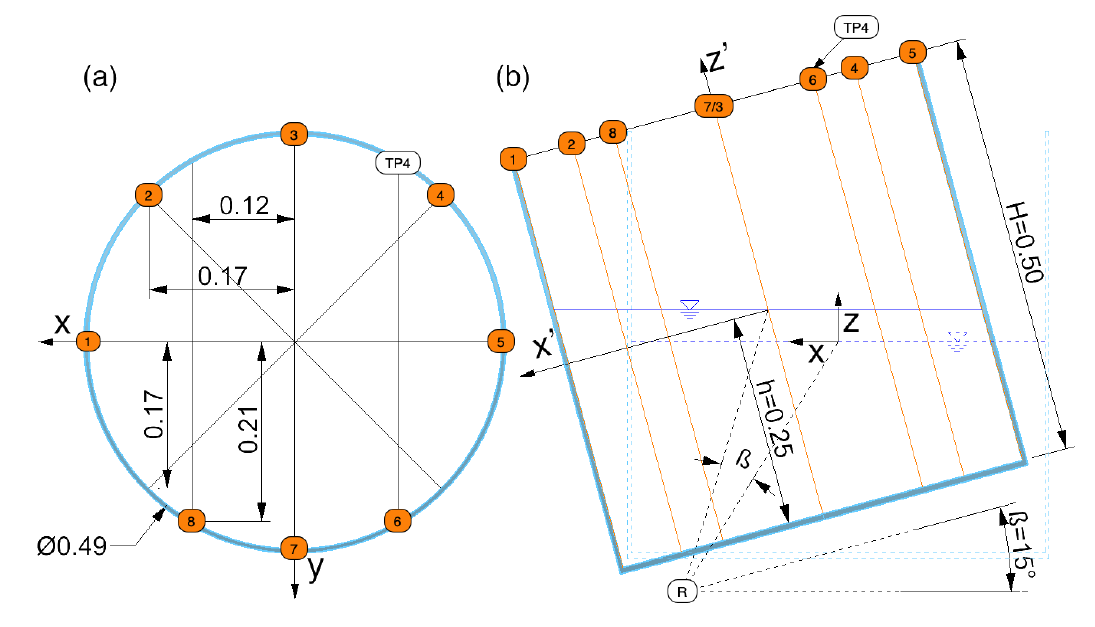
Figure 2. Basic geometry ( a ) plan view of the upright cylinder including the numbering of the wave gauges and ( b ) side view of the inclined geometry with an example pitch angle β — R is the rotation axis and TP 4 the reference point introduced in Section 3.2—all dimensions in